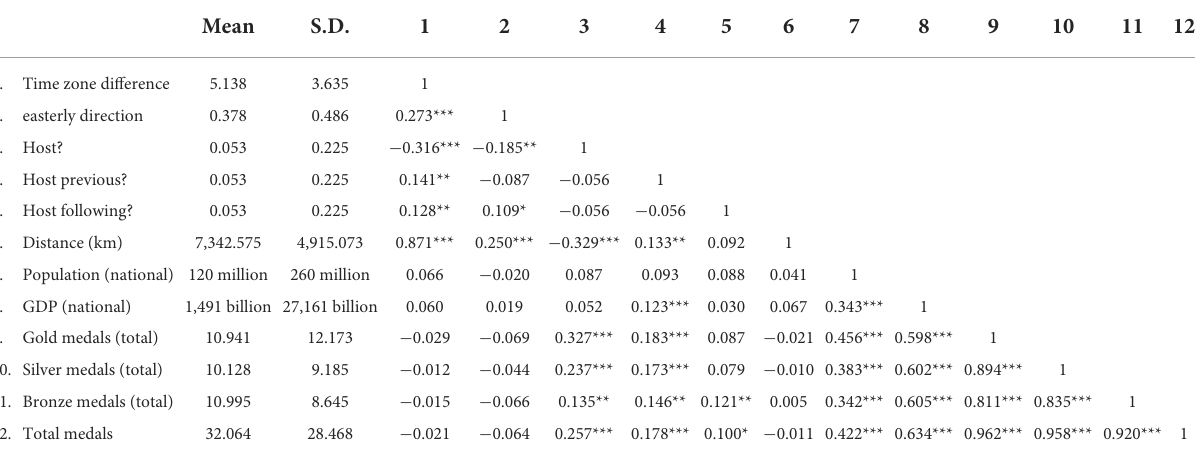
TABLE 2 Descriptive statistics and Pearson correlation matrix.